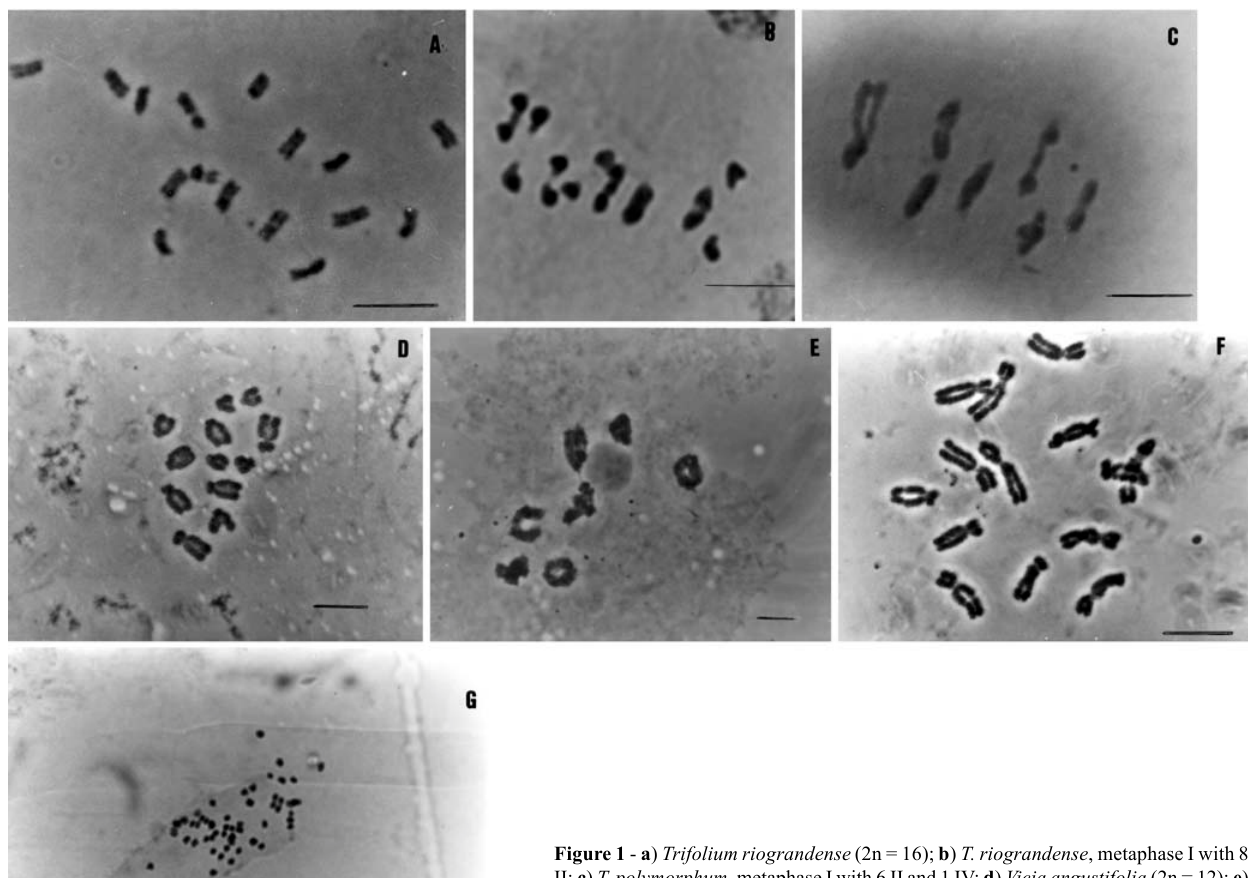
Figure 1 - a ) Trifolium riograndense (2n = 16); b ) T. riograndense , metaphase I with 8 II; c ) T. polymorphum , metaphase I with 6 II and 1 IV; d ) Vicia angustifolia (2n = 12); e ) Lathyrus paranensis, diakinesis with 7 II; f ) L. nervosus , with 2 pairs of chromosomes with secondary constrictions; g ) Leucaena macrophylla subsp. istmensis (2n = 52). Scale = 10 µ